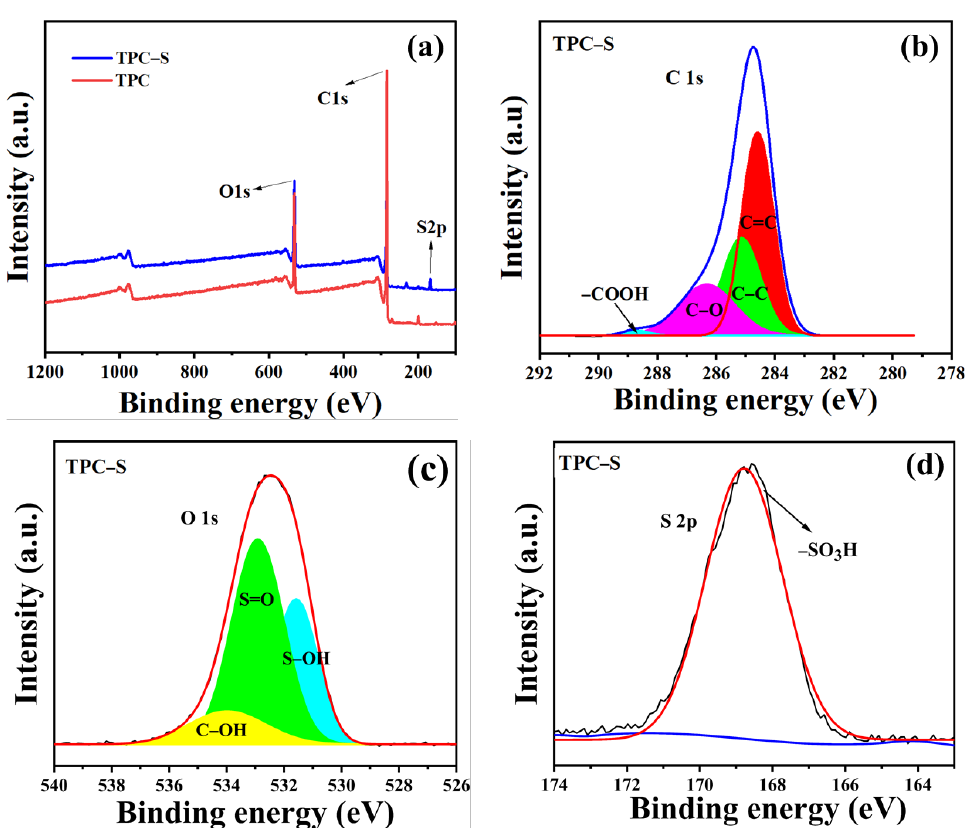
Figure 2. ( a ) XPS spectra of TPC and TPC – S, and ( b ) C 1s, ( c ) O 1s, and ( d ) S 2p XPS spectra of TPC-S.